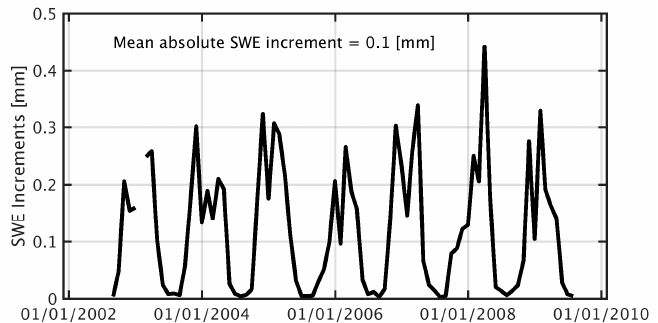
Figure 8. Time series of absolute values of SWE increments (i.e., the difference in DA − OL) averaged across the entire study domain, including the temporal mean of the entire simulation as shown in the title.